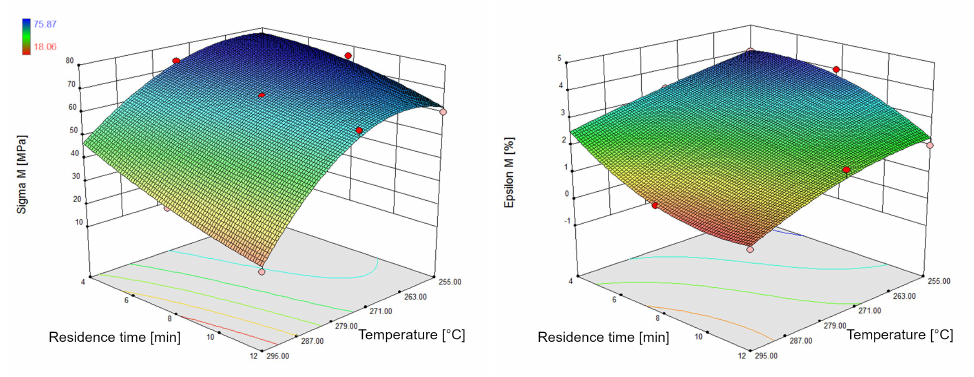
Figure 1. Tensile strength ( left ) and elongation at break ( right ) of a damaged PA6.6 (FRIANYL A63 RV0) specimen at 0.044% moisture